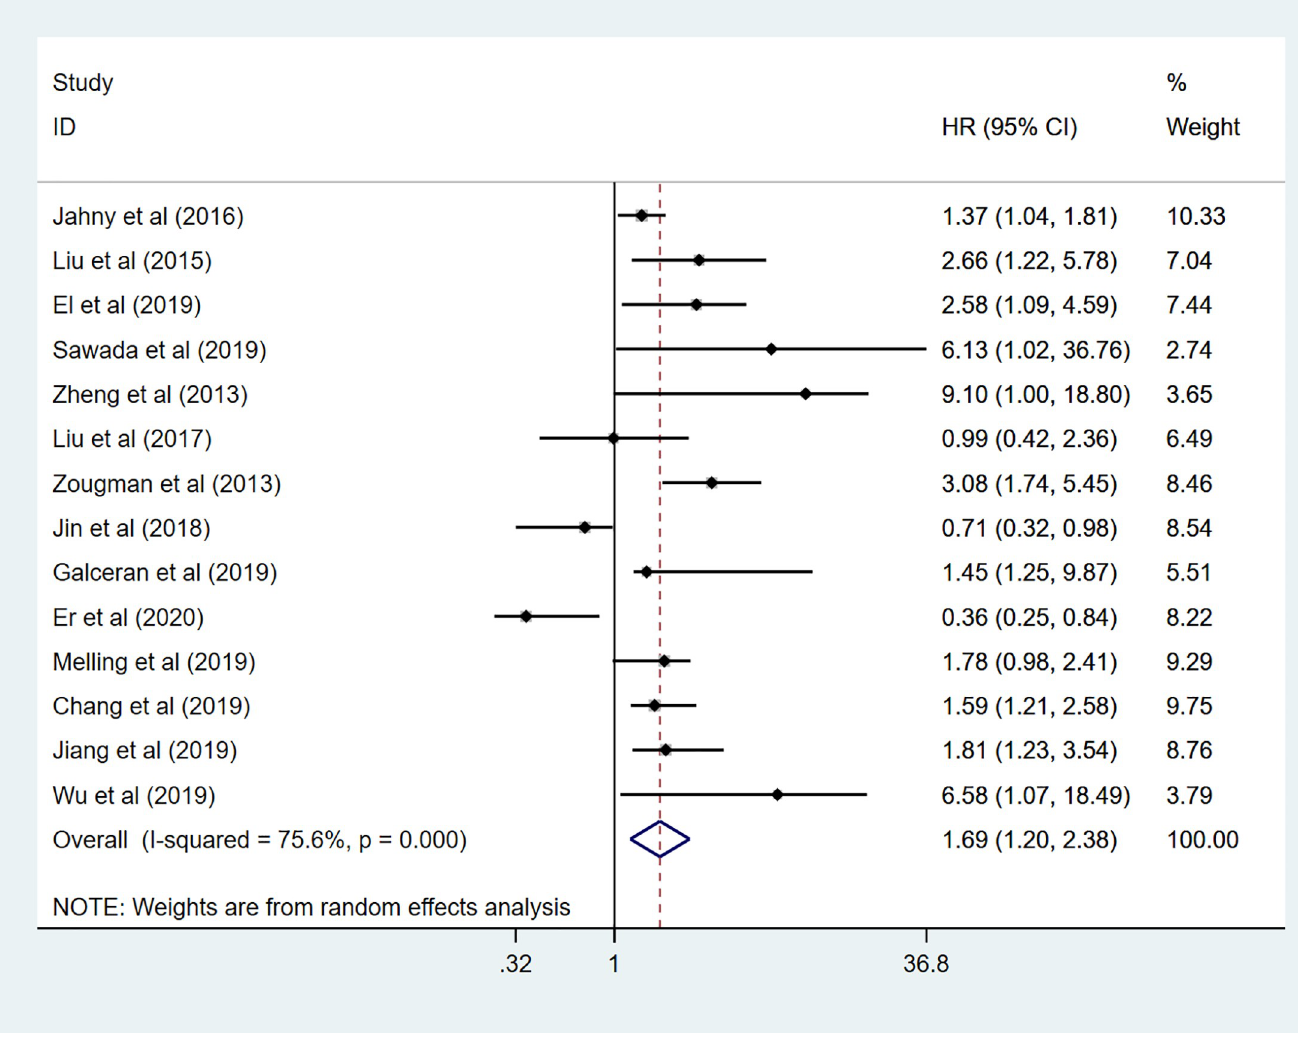
PLOS ONE | https://doi.org/10.1371/journal.pone.0249040 March 31,